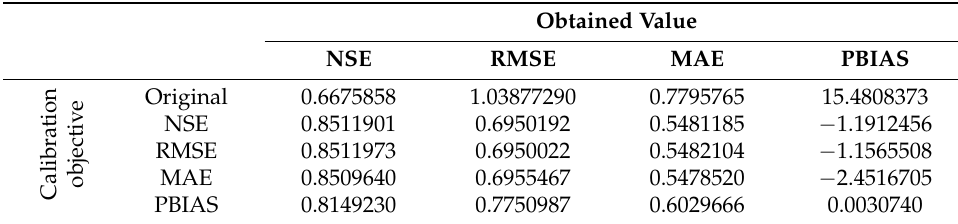
Table 5. The comparison of statistical measures before and after the calibration process of the Turc equation. The first row represents the values of various statistical measures (see columns) of the original model. Remaining rows determine the objective statistical measure, which respect to the model was calibrated. The columns represent the corresponding values of various